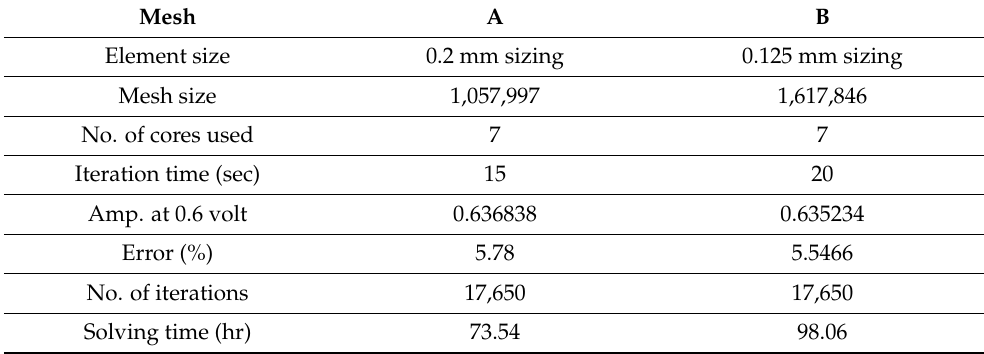
Table 4. Mesh independency analysis.